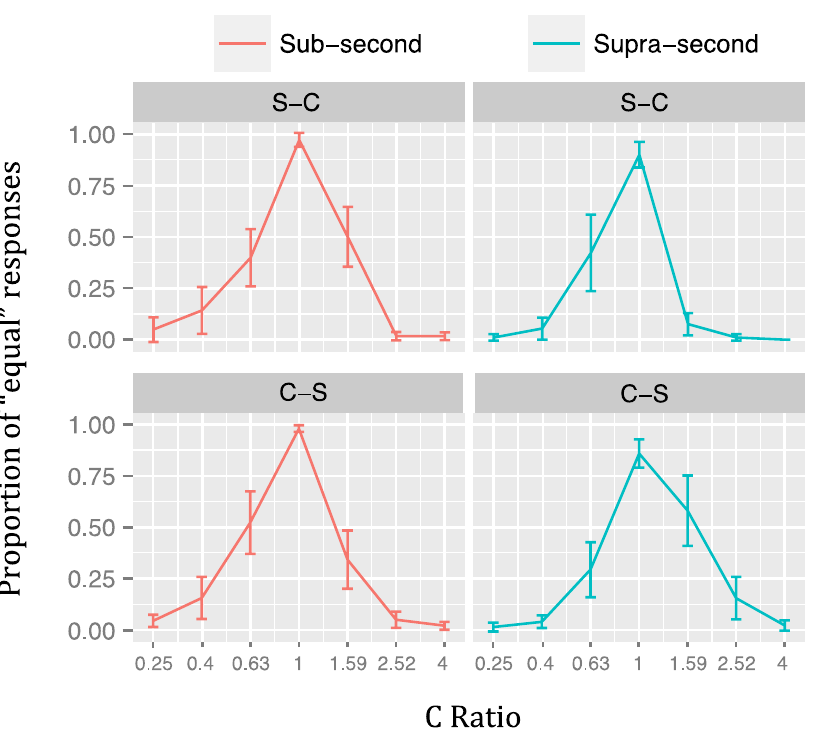
Figure 8. Temporal generalization gradients of Experiment 3 (logarithmically spaced ratios) by presentation order. Proportion of “equal” responses for the Sub-Second (left) and Supra-Second (right) conditions by presentation order. Vertical lines represent 95% confidence